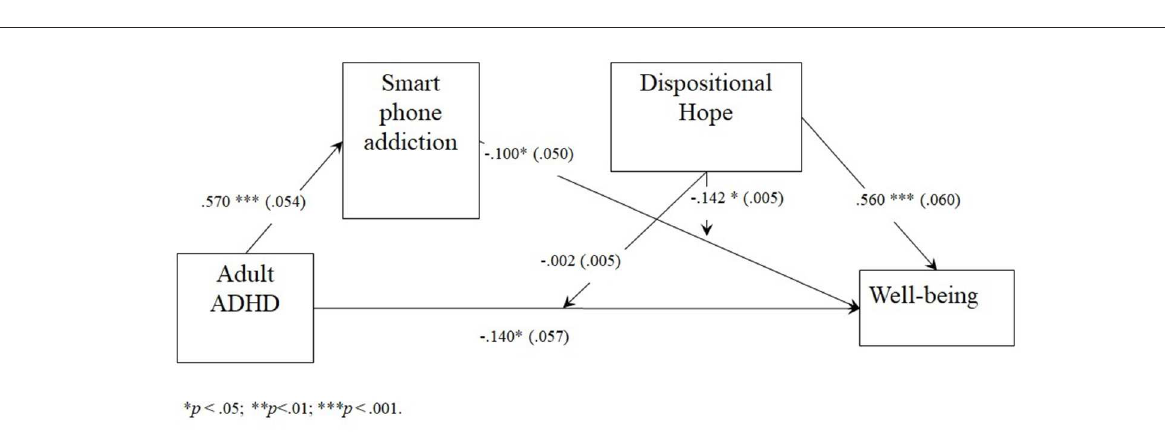
FIGURE2 Moderated mediation model of the ADHD effect on wellbeing through smartphone addiction, moderated by dispositional hope. * p < 0.05; ** p < 0.01; *** p < 0.001.